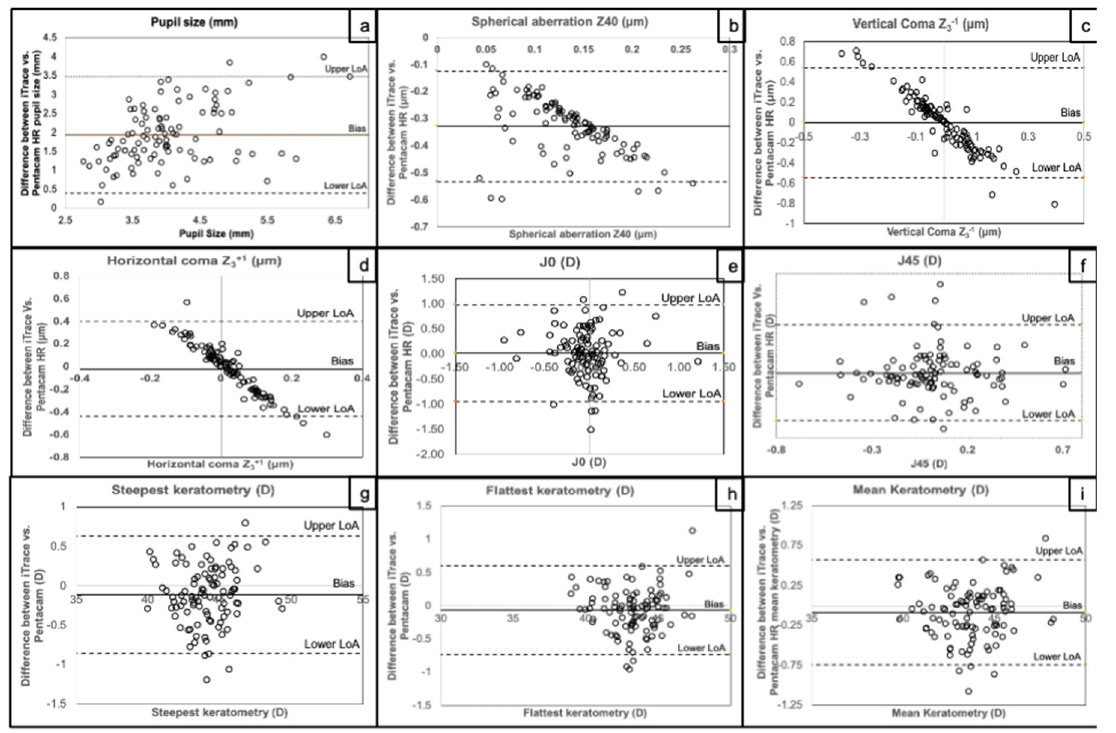
Figure 1. Bland–Altman plot for the difference between iTrace ® and Pentacam HR ® ( a ) for pupil size, ( b ) for spherical aberration, ( c ) for vertical coma, ( d ) for horizontal coma, ( e ) for J0, ( f ) for J45, ( g ) for steepest keratometry, ( h ) for flattest keratometry, and ( i ) for mean keratometry.